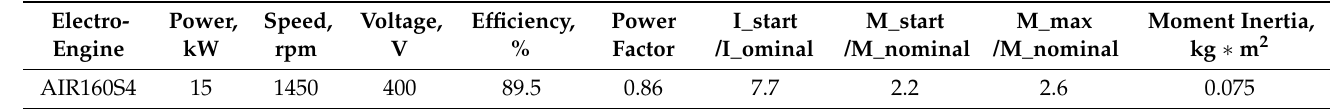
Table 1. Parameters of AIR160S4.